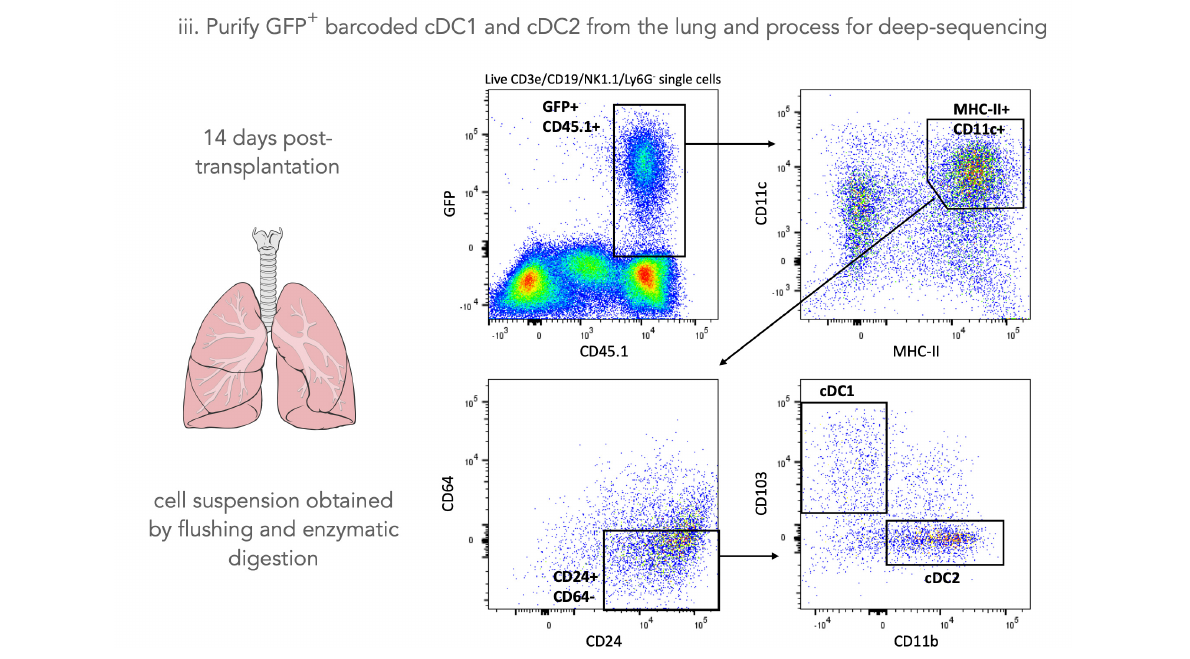
FIGURE3 Lentiviral barcoding of murine hematopoietic progenitors. (A) Our research question is to assess whether a single MPP4 can make both cDC1 and cDC2 lung-resident populations (model 1) or whether they are fate restricted to produce only one of the two cell types (model 2). (B) To address this research question, we purified MPP4 by FACS sorting and labeled cells with a lentiviral barcoding library. Cells were then transplanted into 3 irradiated (6Gy sub-lethal) recipients and left to engraft, divide and differentiate for 14 days. 14 days post-transplantation lungs were harvested and GFP+ (barcode-expressing) cDC1 and cDC2 were purified by FACS sorting, and their genomic DNA was processed for sequencing library preparation as described in the materials and methods section. After sample QC a total of 60 barcodes were recovered for lung cDCs across 3 mice (m1 = 32 barcodes, m2 = 17 barcodes, m3 = 11